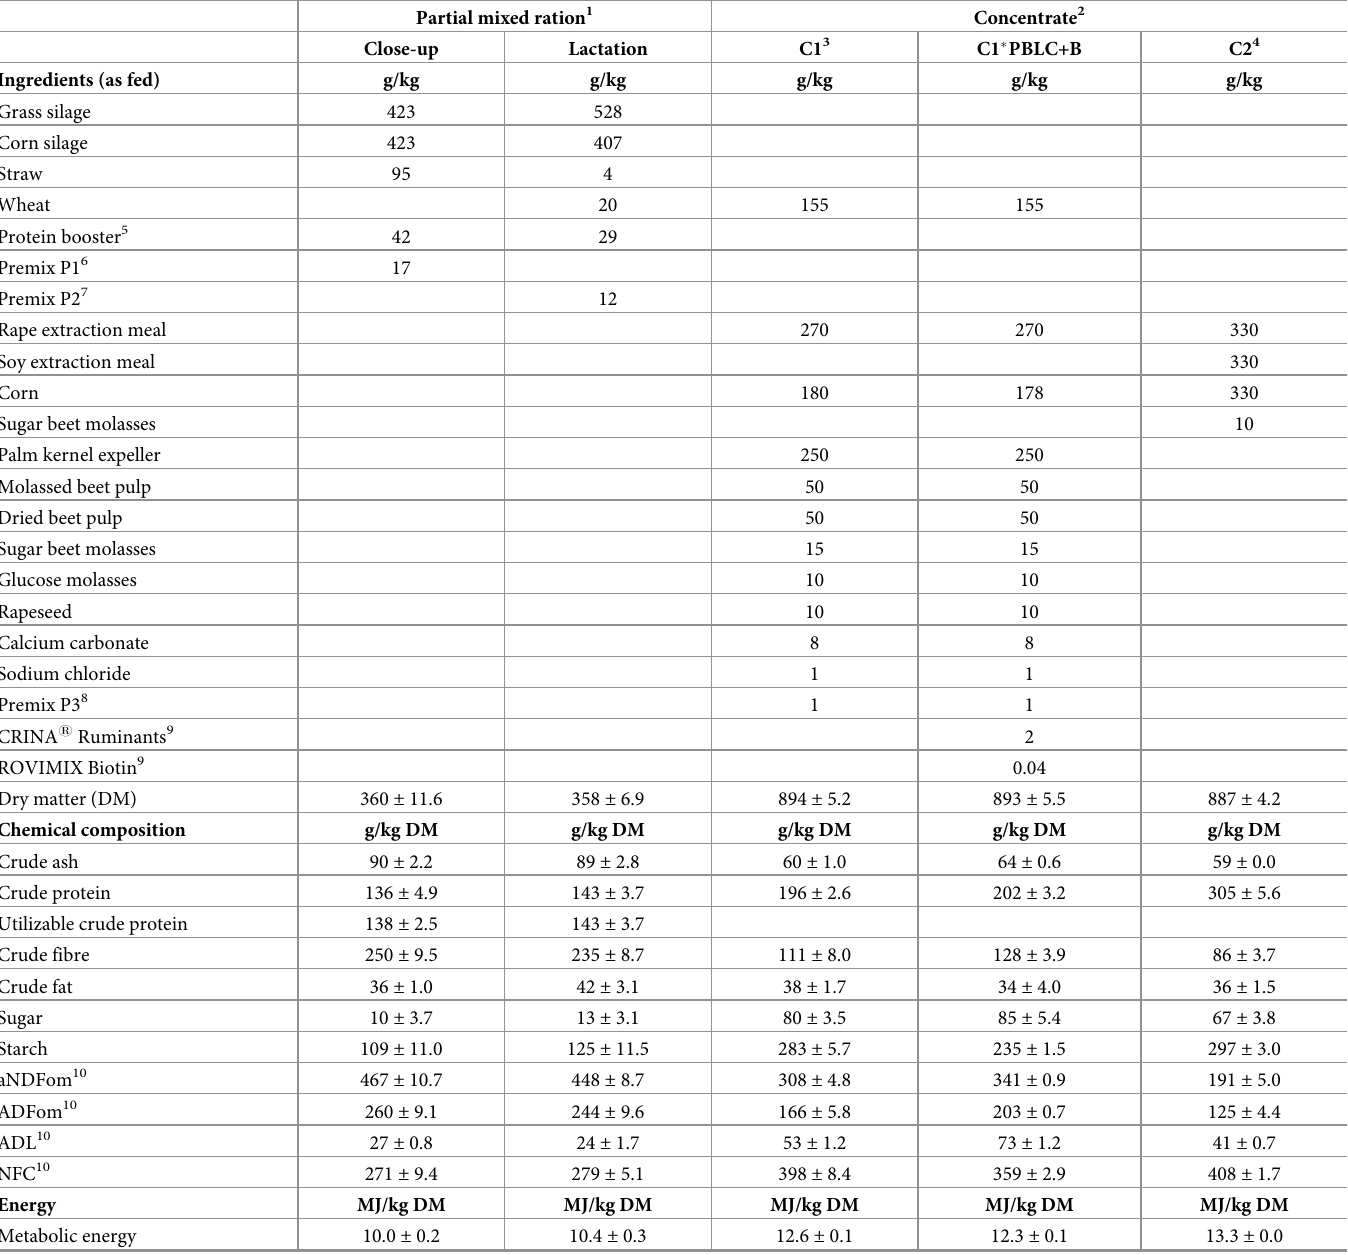
Table 1. Ingredients, analyzed chemical composition and energy contents of partial mixed ration and concentrates used in close-up and lactation